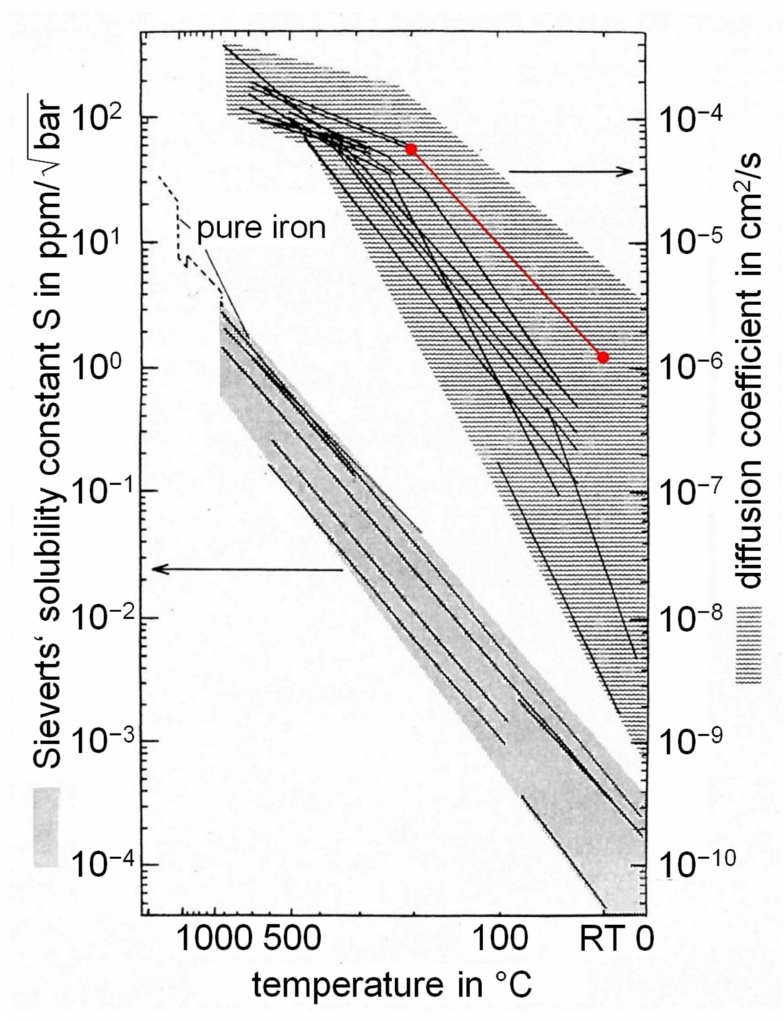
Figure 6. Sieverts‘ solubility constant and diffusion coefficient of hydrogen in pure iron from the literature according by Streng [23] and the values determined within this work marked in